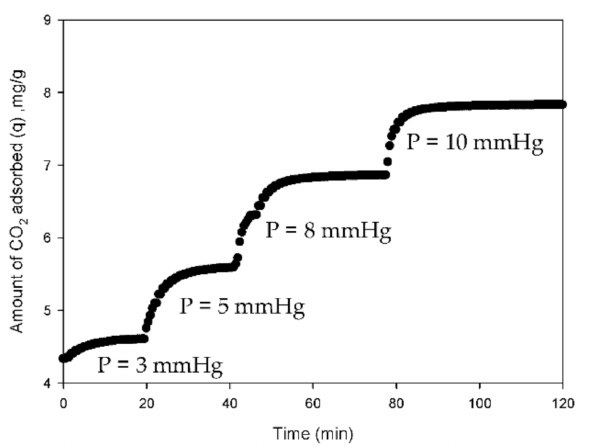
Figure 13. Typical adsorption kinetic data collected at various pressures.